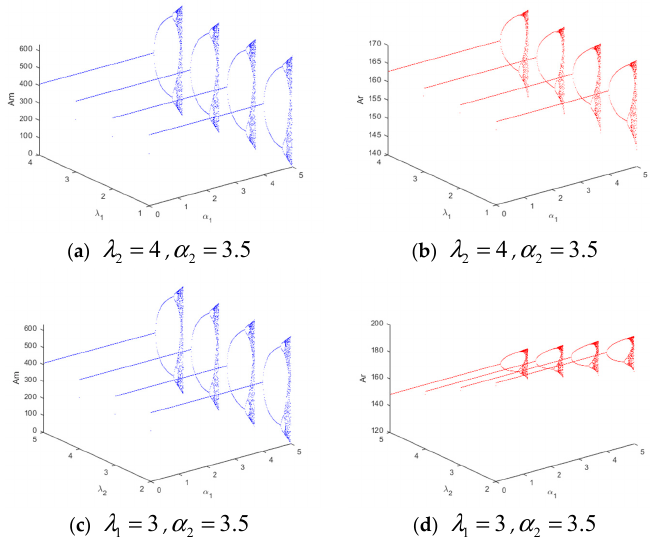
Figure 12. The 3D bifurcation diagrams of A m and A r with respect to α 1 with ( a , b ) λ 1 = 1,2,3,4 and ( c , d ) λ 2 = 2,3,4,5.